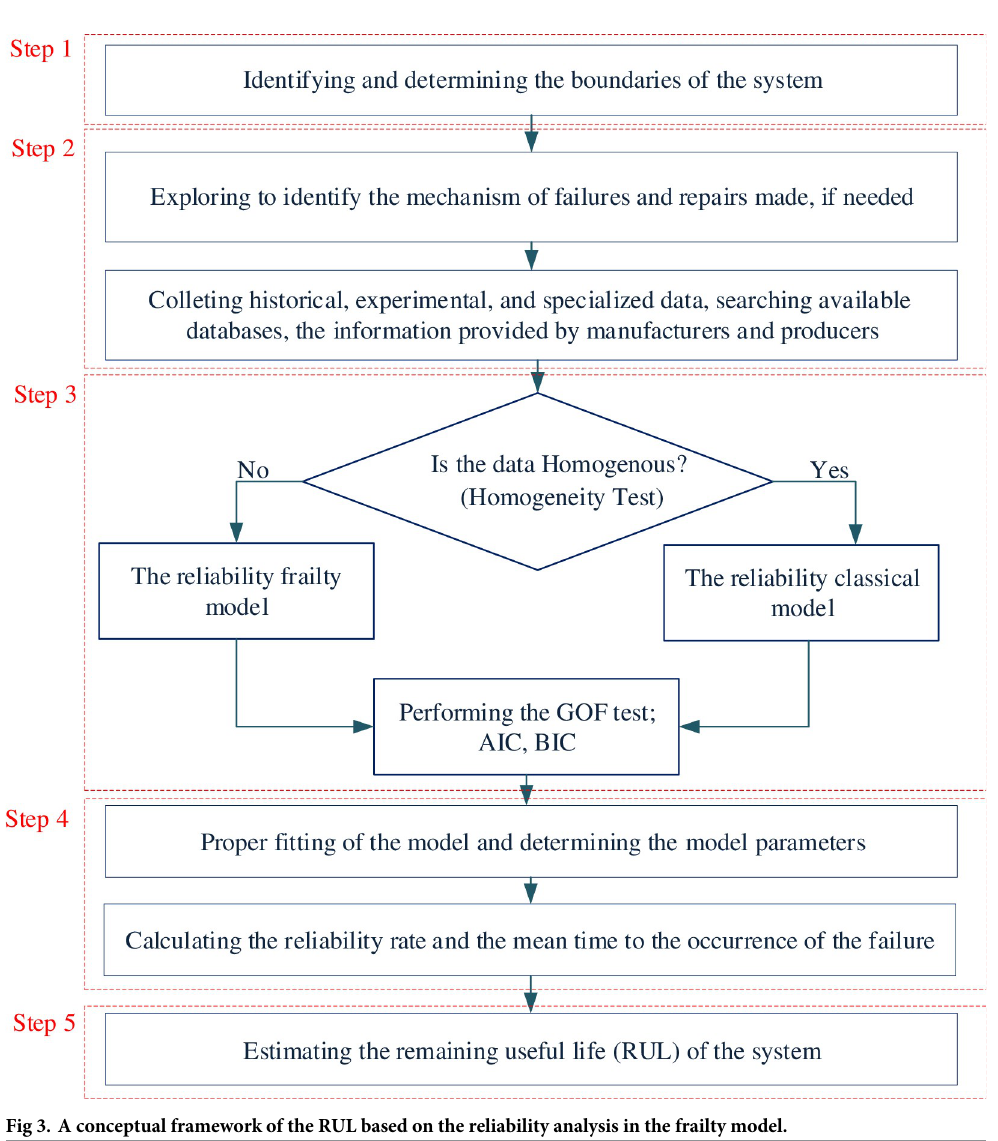
Fig 3. A conceptual framework of the RUL based on the reliability analysis in the frailty